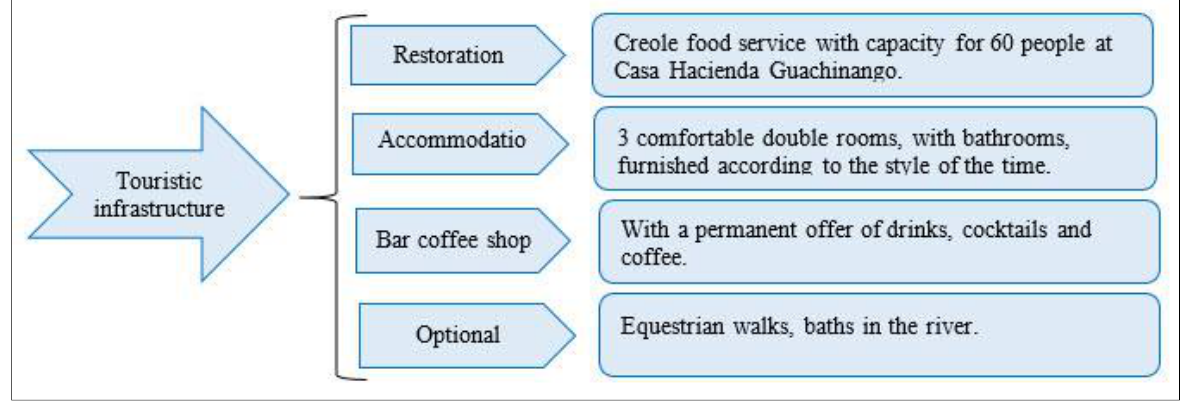
Figure 5. Tourism infrastructure available for agrotourism at Hacienda Guachinango. Source: own elaboration based on the results of the inventory of resources at Hacienda Guachinango.